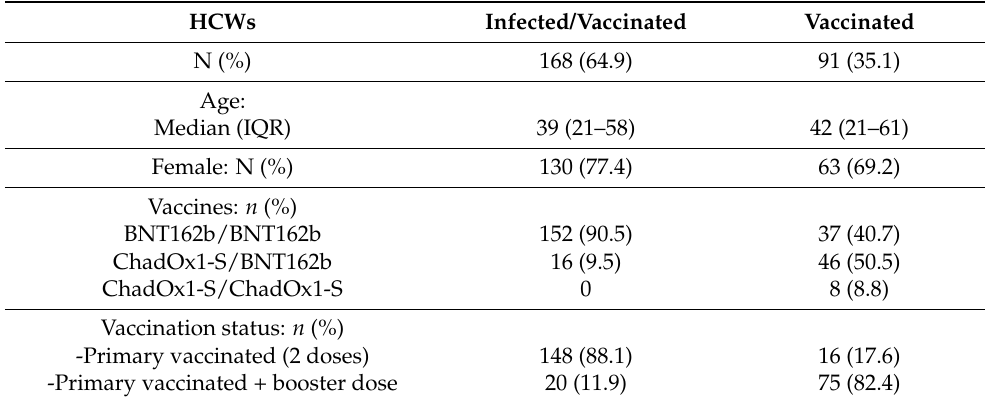
Table 1. HCW characteristics according to infectious status: infected then vaccinated or vaccinated without a past infection.